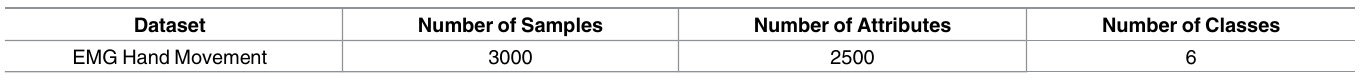
Table 2. Characteristics of the EEG Dataset Used in the